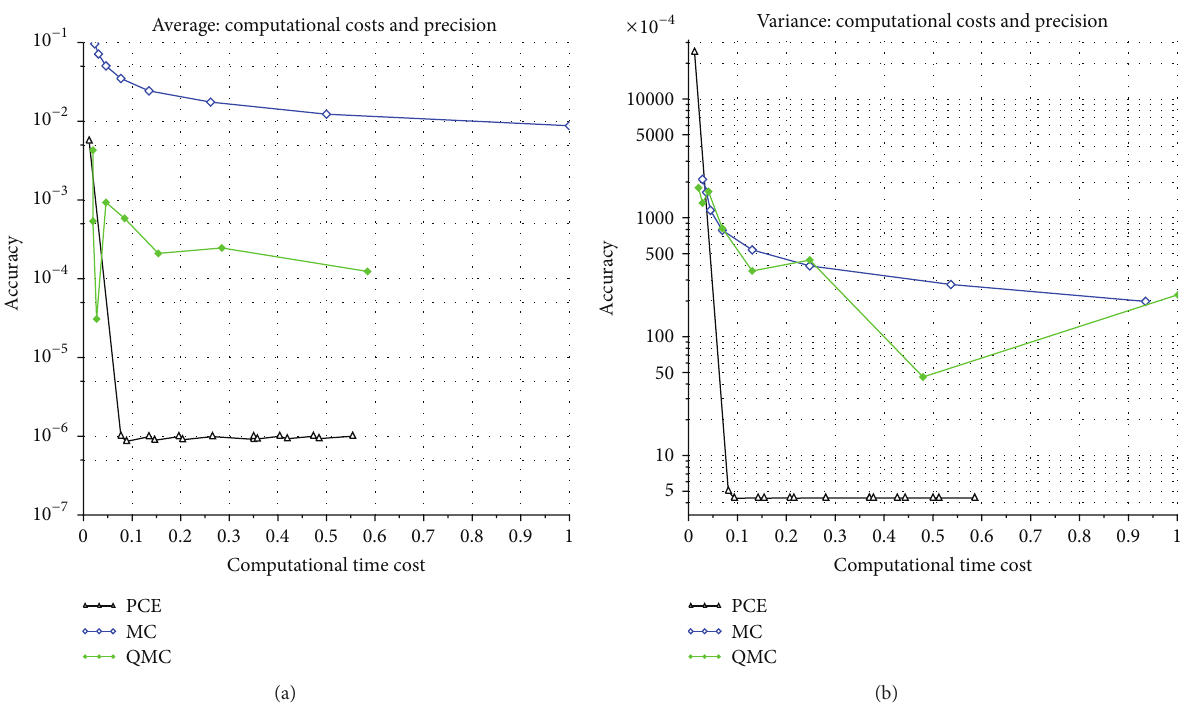
Figure 21: Semilogy scale plot which compare the accuracy and computational time costs for detecting the average (a) and variance (b) of the CIR model at 𝑇 = 1 by means of PCE, MC, and QMC approaches, with parameters 𝛼 = 0.1 , 𝛽 = 0.002 , and 𝜎 = 15 %.